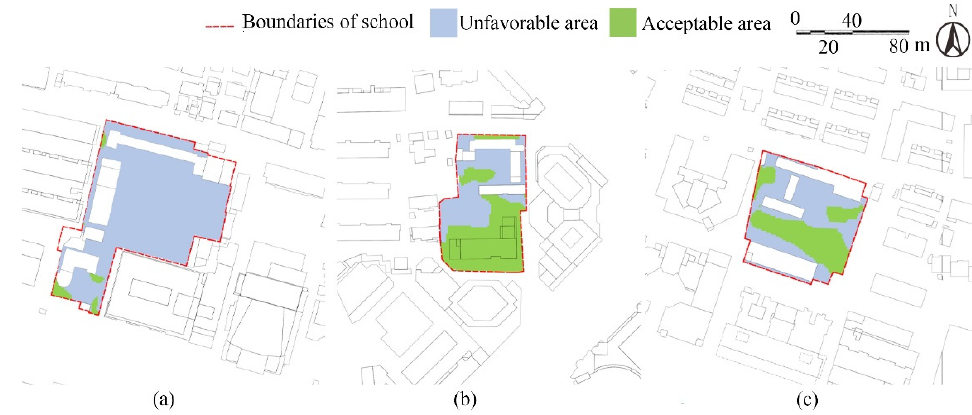
Figure 10. Distribution of wind comfort zones at the pedestrian level at three primary schools in summer in the 2010s: ( a ) Changjiang Road Primary School; ( b ) Chibi Road Primary School (Shanxi Road Campus); ( c ) Jianye Road Primary School.